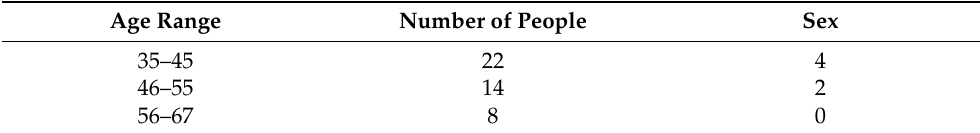
Table 1. Sociodemographic characteristics of the